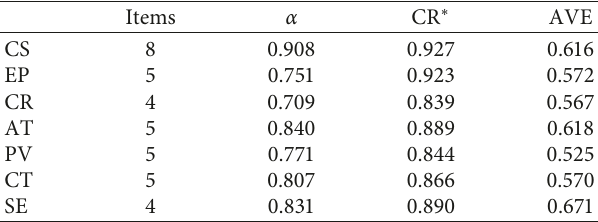
Table 4: Exploratory factor